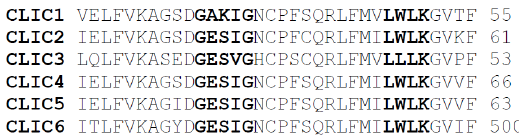
Figure 3. Amino Acid Sequence Alignment of Human CLIC proteins showing the CRAC motif. Highlighted in red is the GXXXG motif and in Green highlighted the LWLK motif in human CLICs.